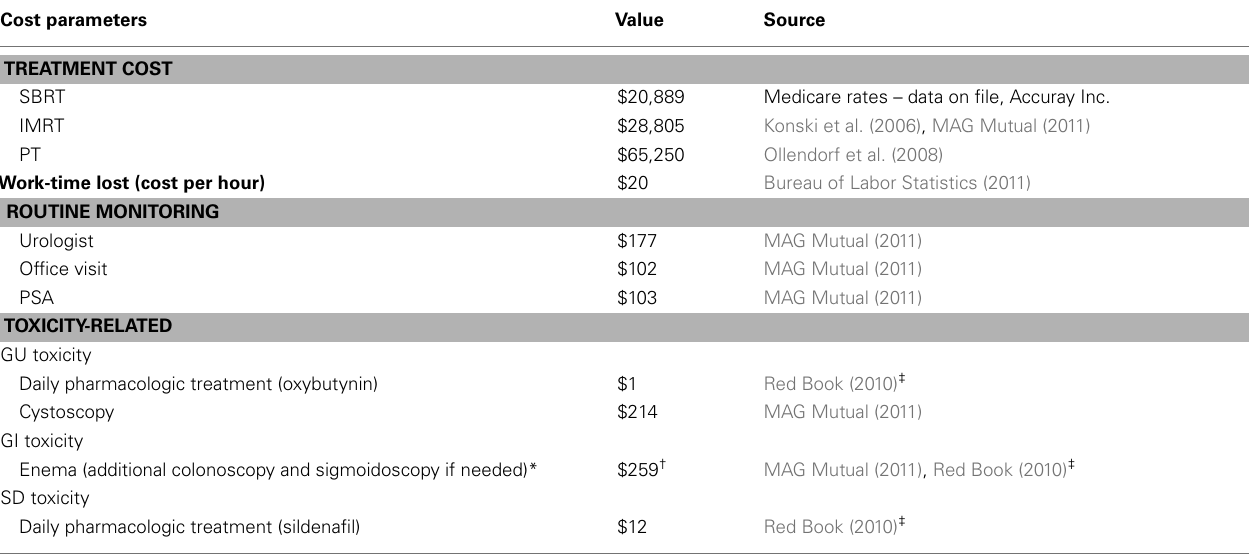
Table 5 | Model cost